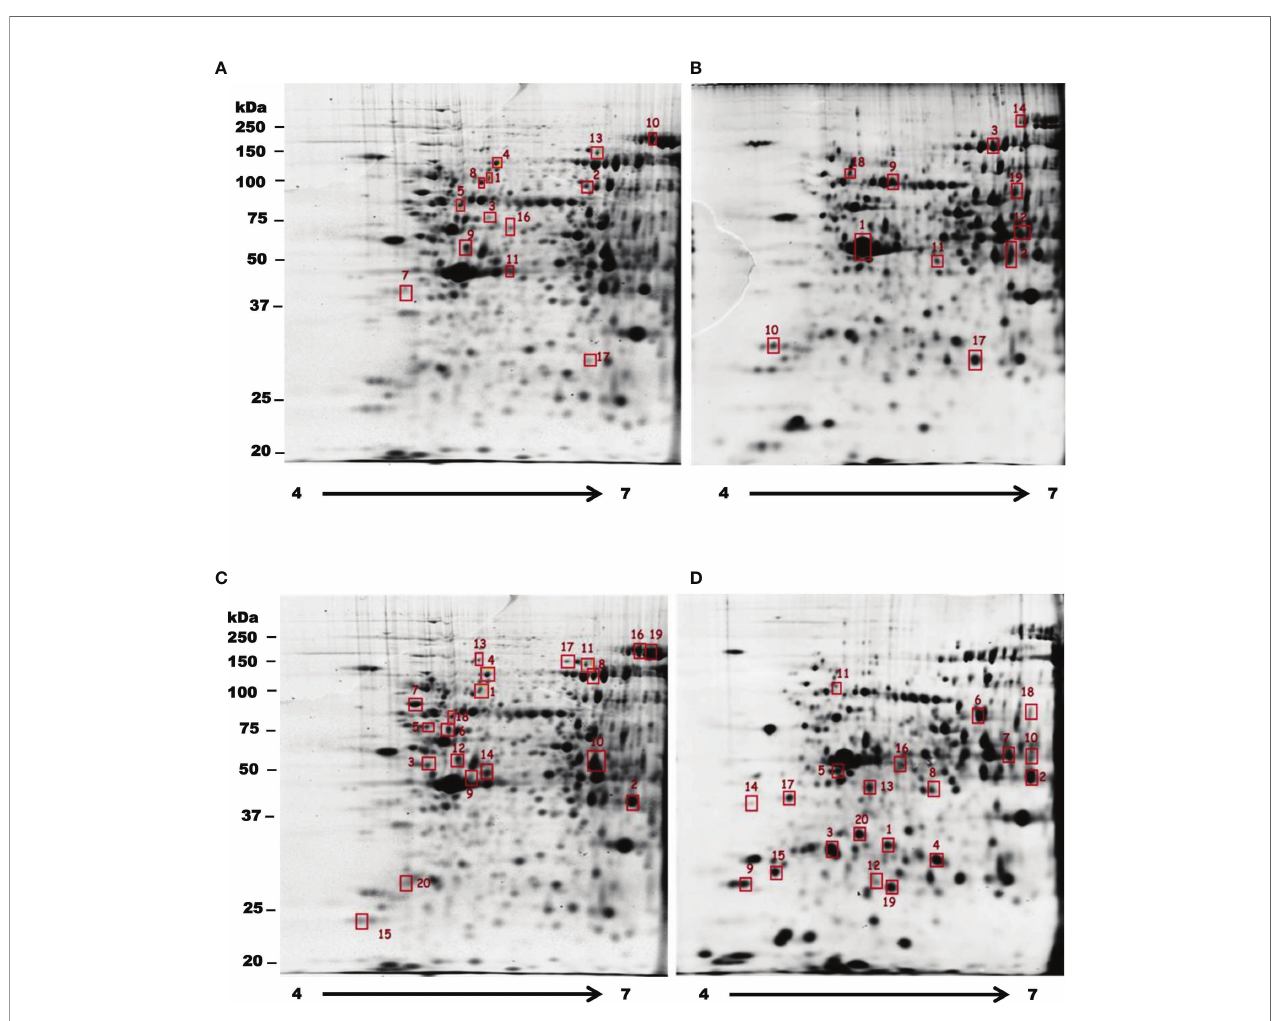
FIGURE 1 | Two dimensional differential in gel electrophoresis of E. histolytica trophozoite proteins under the effect of T-001 and T-017. Selected spots for protein identi fi cation corresponding to proteins with a differential abundance between control trophozoites (A, C) and parasites treated with T-001 (B) or T-017 (D) are indicated in red squares. Underexpressed proteins are marked on gels of untreated trophozoites (A, C) and the overexpressed ones are indicated on gels of trophozoites treated with T-001 and T-017 (B, D) . The isoelectric focusing was carried out in a non-linear gradient of pH